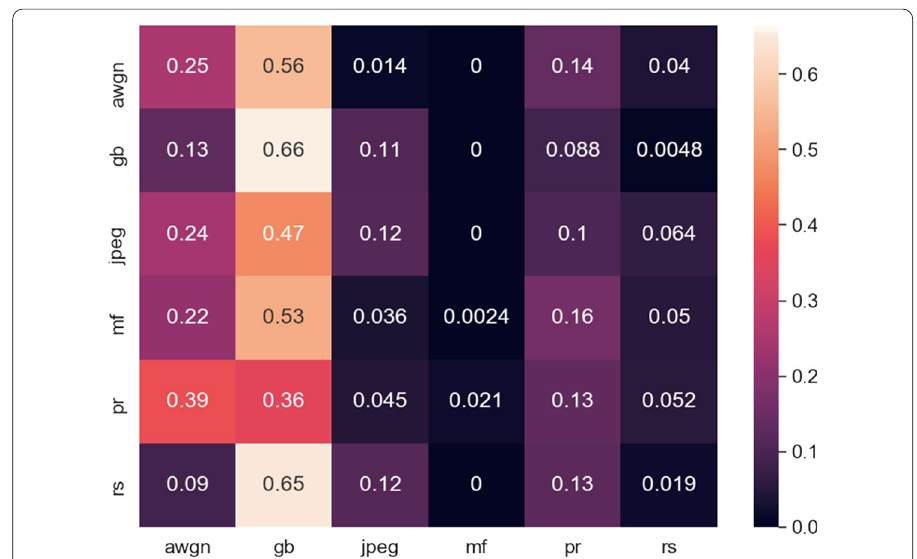
Fig. 4 Confusion matrix for Bayar2016 trained on original IFSTC, evaluated on Xerox1 (see Table 2, Xerox1). We note that despite the high reported validation accuracy on the original data set, the model struggles to distinguish between the classes after printing and scanning